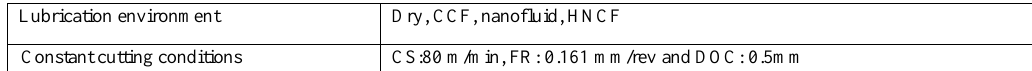
Table 1. Cutting conditions for turning of AISI 1040